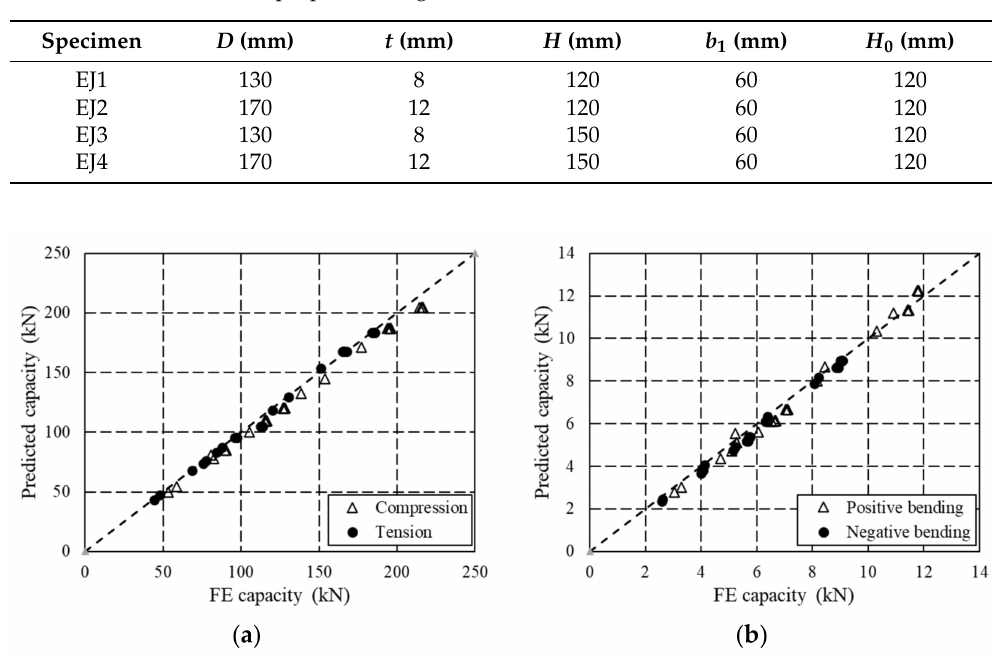
Figure 22. Verification of the design method: ( a ) compressive and tensile capacities; ( b ) bending